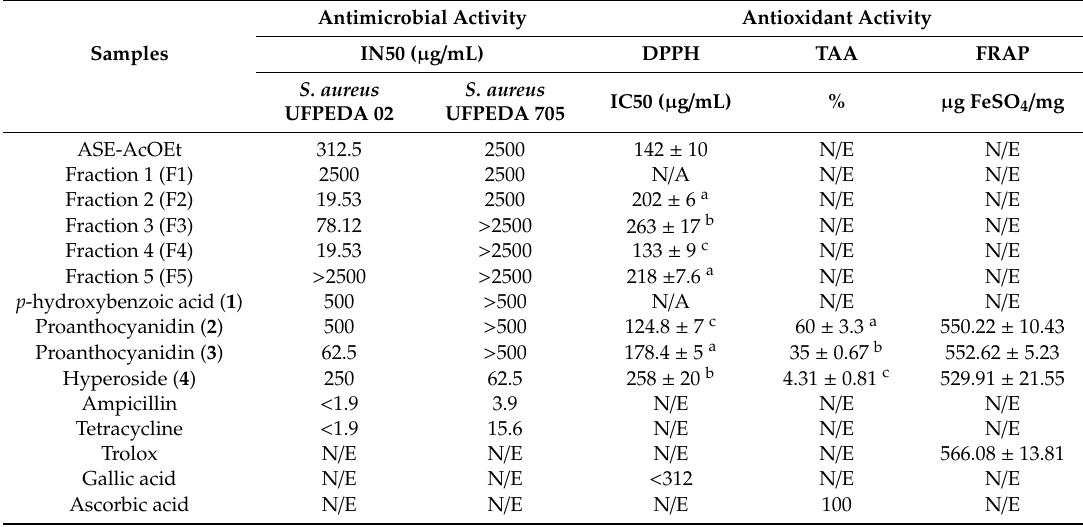
Figure 2. 3D chromatogram of fractions F1, F2, F3, F4, and F5. The chromatogram 3D allows visualizing the compounds by means of their respective UV spectra ( 1 : p -hydroxybenzoic acid, 2 and 3 : proanthocyanidins and 4 : hyperoside), their position in the chromatogram with respect to time on a scale of 190 to 400 nm. mAU: Signal strength; nm: wavelength; t: time. Table 1. Antimicrobial and antioxidant assay of the extract, fractions and compounds isolated from Anadenanthera colubrina var cebil